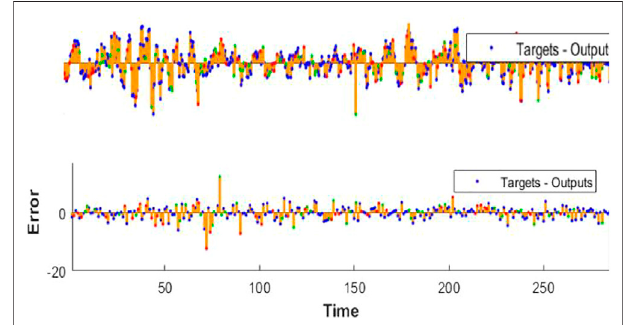
FIGURE 7 | Error comparison chart between BP and